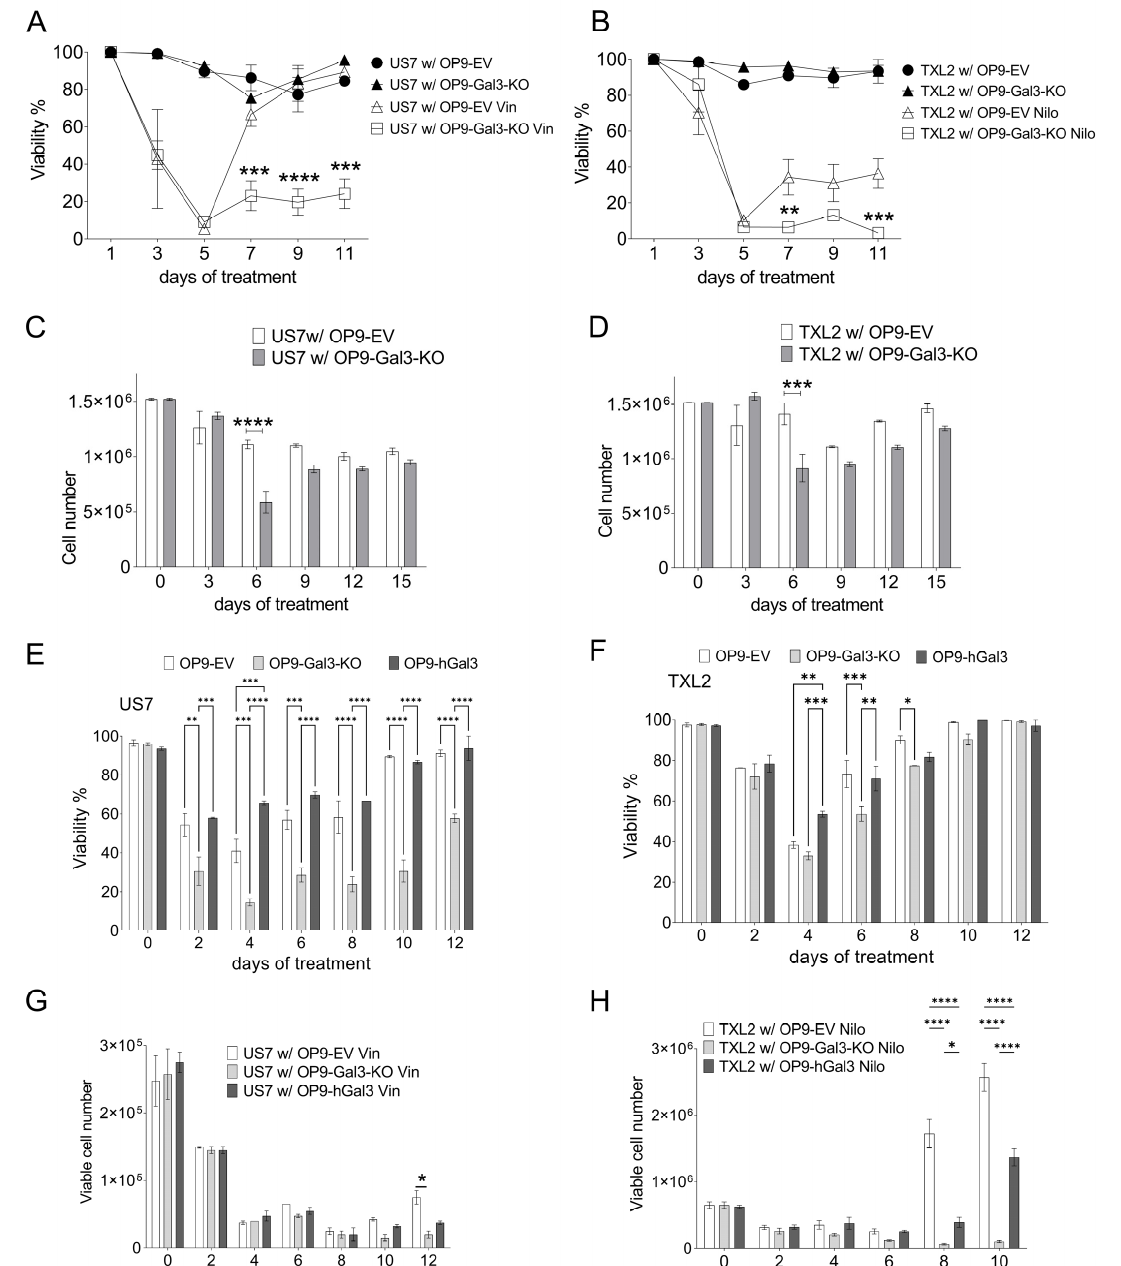
Figure 4. Depletion of Gal3 in stromal cells significantly enhances BCP-ALL cell response to chemotherapy. ( A ) Viability of US7 cells grown on the indicated OP9 cells treated with solvent as control, or with 2 nM vincristine. ( B ) Viability of TXL2 cells plated on different OP9 cells and treated with 20 nM nilotinib. Panels ( A , B ): 2-way ANOVA comparing samples per time point, Tukey’s multiple comparison test; only statistical analysis of comparisons between vincristine-treated cells on OP9-Gal3-KO and OP9-EV are shown. ( C ) Cell numbers of analysis similar to panel ( A ). ( D ) Cell numbers of analysis similar to panel B . Panels ( C , D ): 2-way ANOVA comparing samples at each time point, Šid á k’s multiple comparison test. ( E ) Viability of US7 cells grown on the indicated OP9 cells treated with solvent as control, or with 2 nM vincristine ( F ) Viability of TXL2 cells plated on the different OP9 cells and treated with 20 nM nilotinib. ( G ) Cell numbers of samples in panel ( E ). ( H ) Cell numbers of samples in panel ( F ). OP9-Gal3 KO cells reconstituted with human Gal3 are indicated as hGal3. Panels ( E – H ): 2-way ANOVA comparing samples at each time point, Tukey’s multiple comparison test. Only values with significant differences are shown. Other comparisons, not significantly different. Panels ( A – D ): error bars, mean ± SEM of 3–4 replicates per time point. Panels ( E – H ): two replicates per time point. * p < 0.05, ** p < 0.01, *** p < 0.001, **** p < 0.0001. Viability is the percentage of Trypan blue excluding cells/total